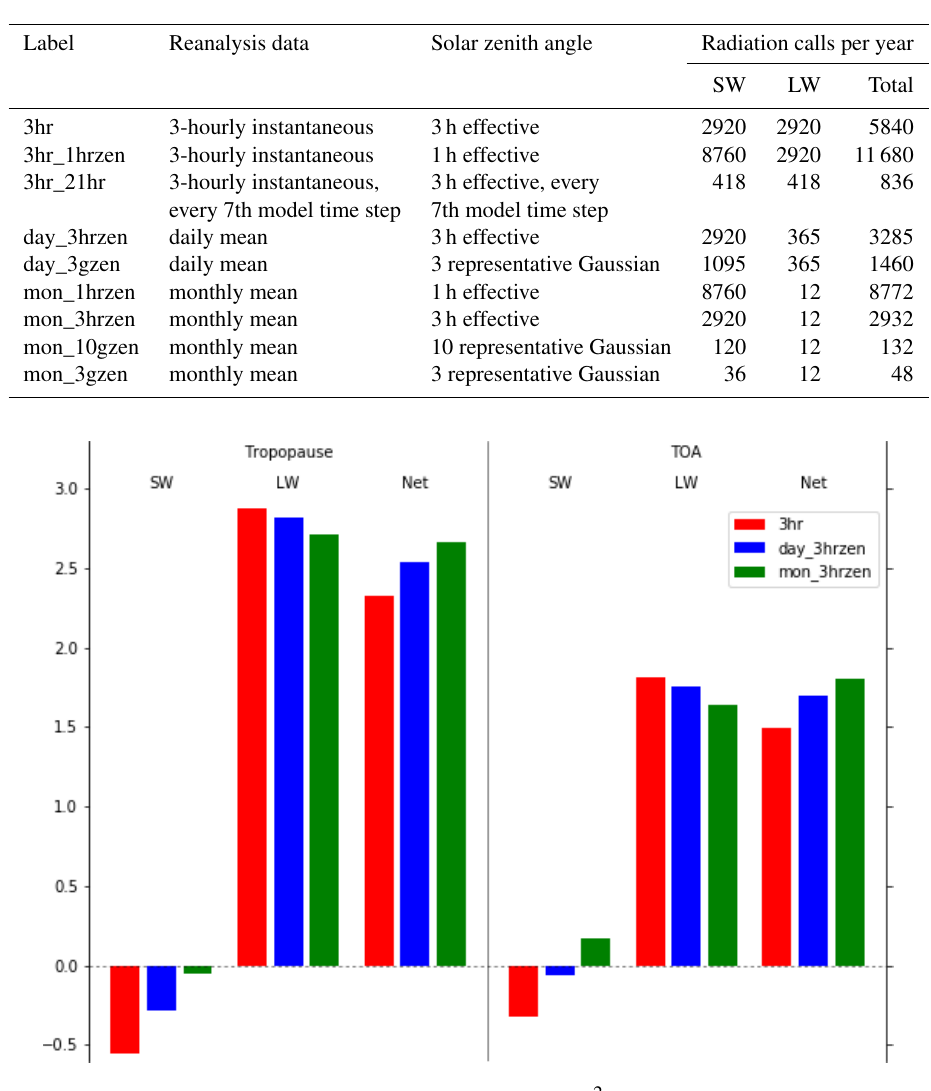
Figure 8. Global-mean instantaneous radiative forcing for the year 2003 (in Wm − 2 ) at the tropopause and top of atmosphere for 3-hourly solar zenith angle time steps for 3-hourly, daily, and monthly